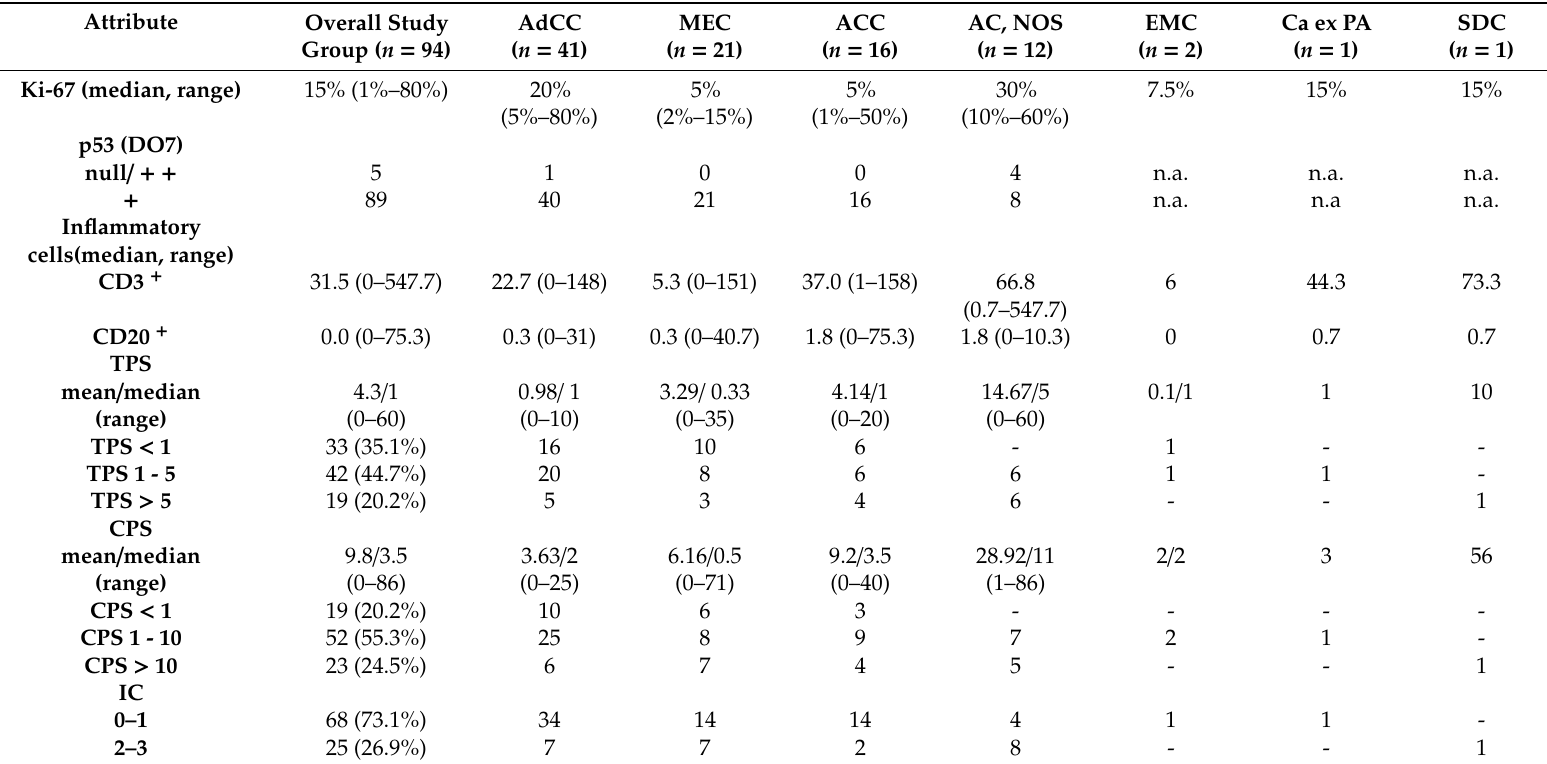
Table 2. Immunohistochemical findings in the study